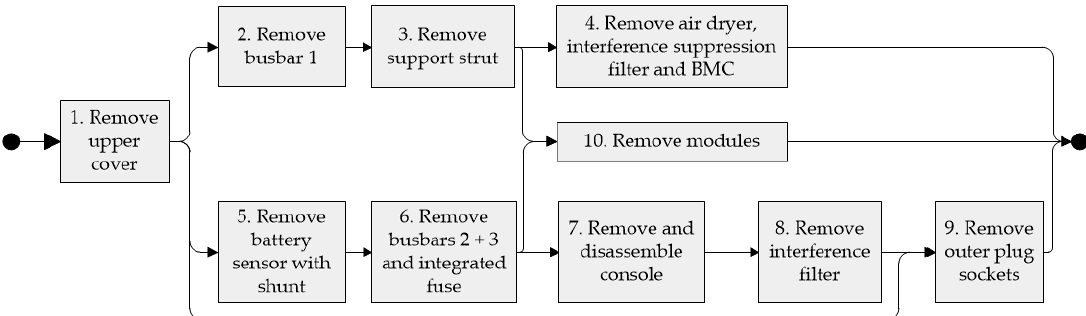
Figure 5. Disassembly graph